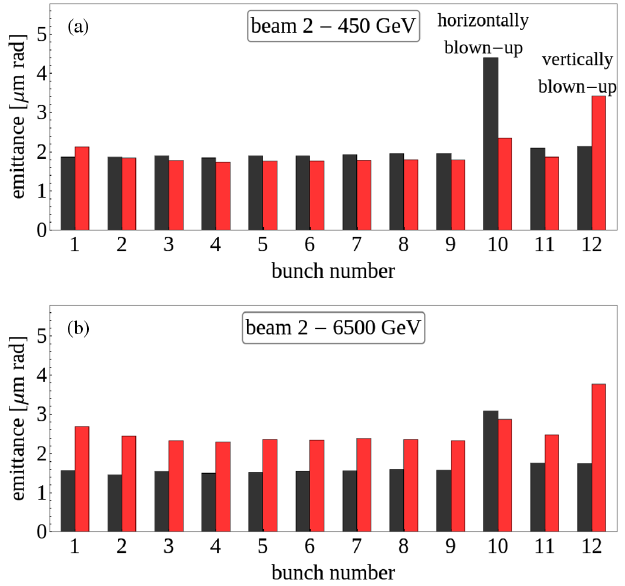
FIG. 10. Measured horizontal (black) and vertical (red) emit- tances of the first 12 bunches in beam 2, (a) at injection energy directly after setup and (b) at top energy after beams started